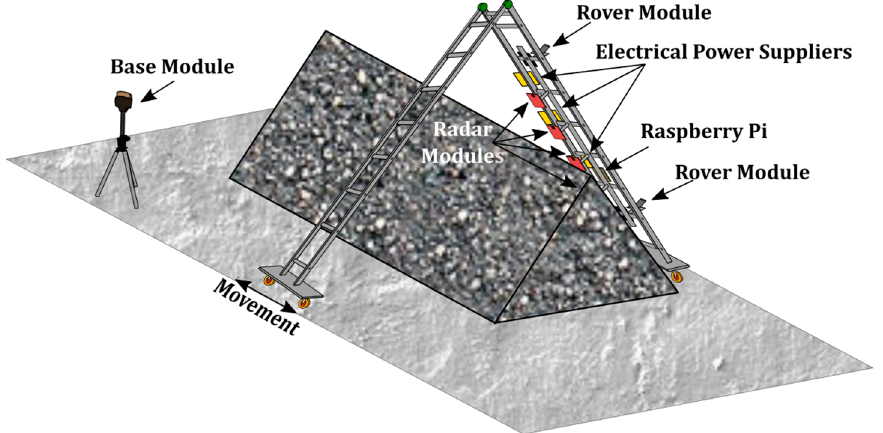
Figure 3. Scheme of the proposed system.